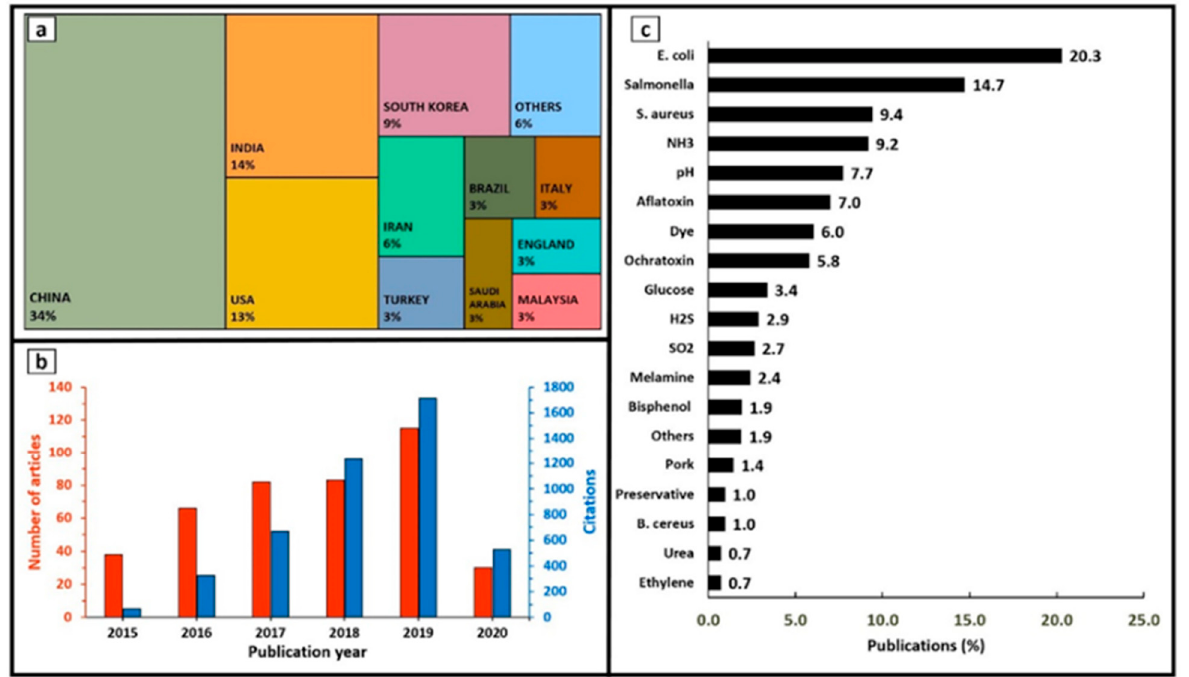
Figure 1. Number of foodborne diseases due to foodborne outbreaks in 2010–2021 Reprinted with permission from ref. [5].